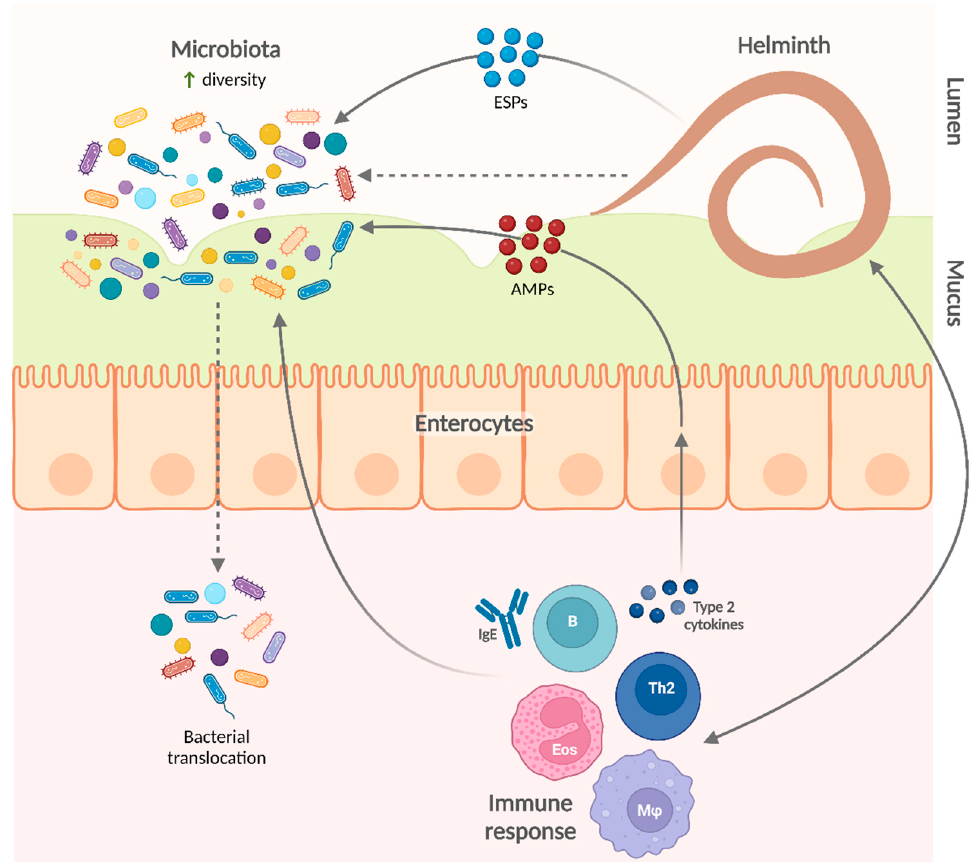
Figure 3. Mechanisms involved in the influence of helminth infections on the microbiota. Helminths can modify the gut microbiota composition by several mechanisms and are generally associated with a more diverse gut microbiota. AMPs, antimicrobial products; B, B cell; Eos, eosinophil; ESPs, excretory-secretory products; IgE, immunoglobulin E; M φ , macrophage; Th2, type 2 helper T cell.